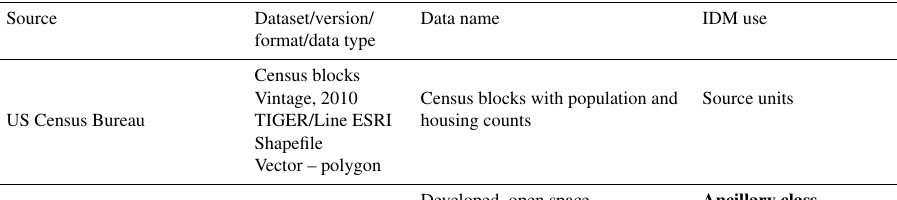
Table 1. Datasets used for updating the EnviroAtlas dasymetric population map. IDM uses in bold were used in the 2016 EnviroAtlas dasymetric population map (m/u: possible mixed-use